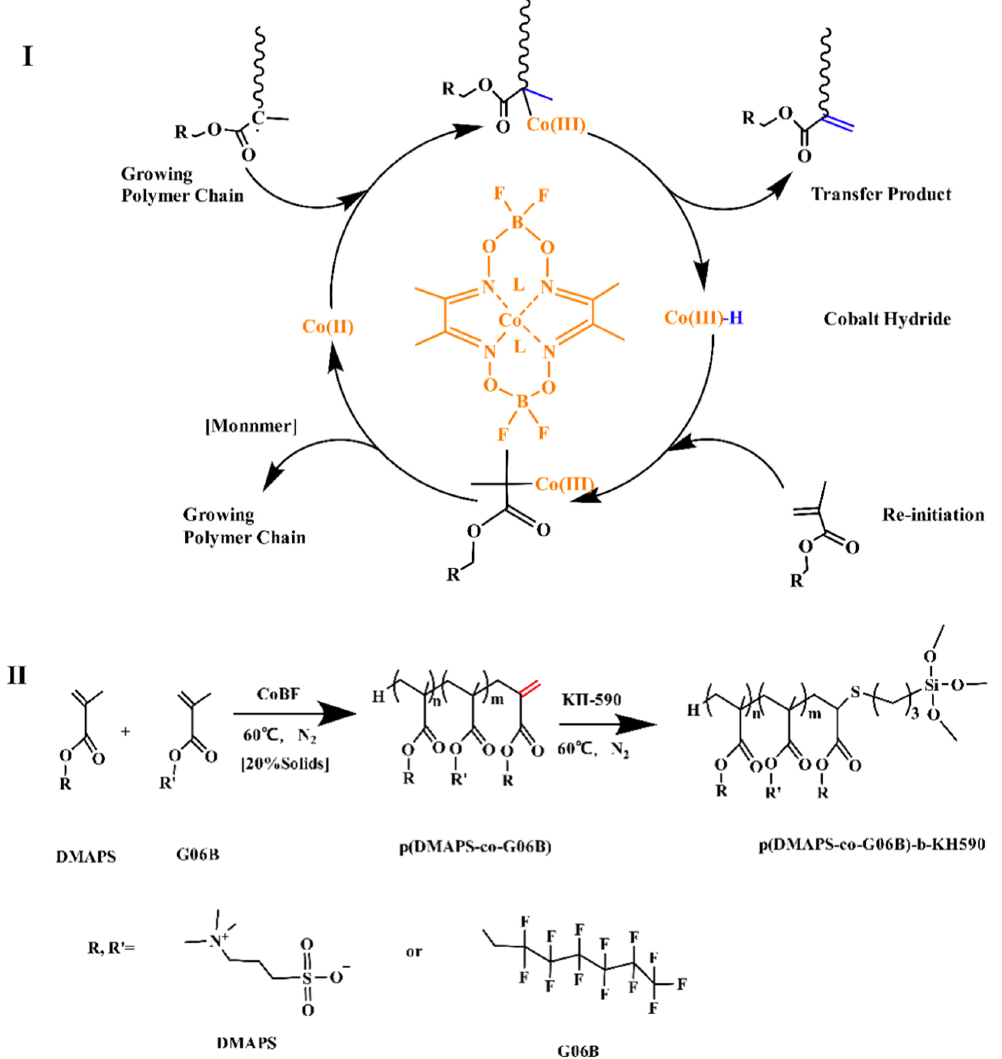
Figure 1. Synthesis diagram and flowchart of the synthesis process of betaine copolymer: ( I ) synthesis process; ( II ) synthesis diagram via CCTP.